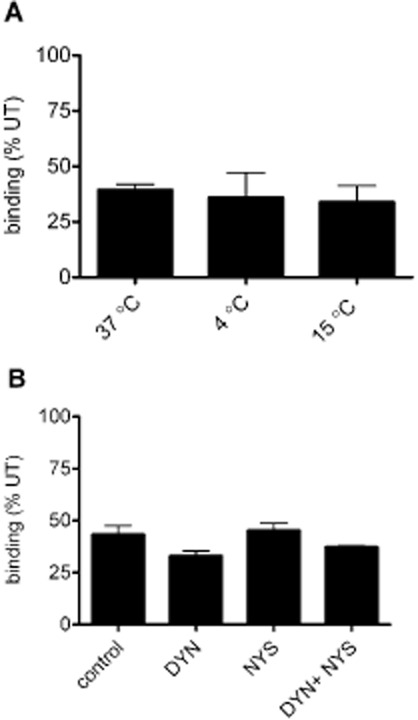
The inhibition of endocytosis does not prevent the palonosetron-mediated down-regulation of 5-HT3 receptor binding sites. [3H]granisetron binding was performed on 5-HT3A-expressing COS-7 cells. (A) Palonosetron (1 nM) pretreatment (150 min) at 4, 15 or 37°C and incubated in drug-free buffer for 150 min, at the same temperatures, prior to radioligand binding. (B) Palonosetron (1 nM) was incubated in the presence of dynasore (DYN, 80 μM), nystatin (NYS, 21 μM), or both and incubated at 37°C (150 min). Following incubation in drug-free buffer (150 min) radioligand binding was performed (37°C). Data are expressed as % of untreated cells and experiments were performed on three independent occasions in triplicate.